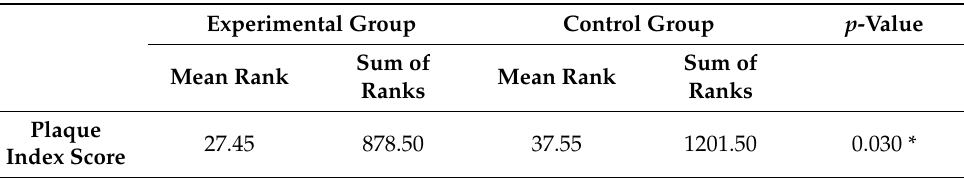
Table 5. Comparison Between Differences in Oral Hygiene Status Before and After the Use of the Dental Visual Aids Between Groups.